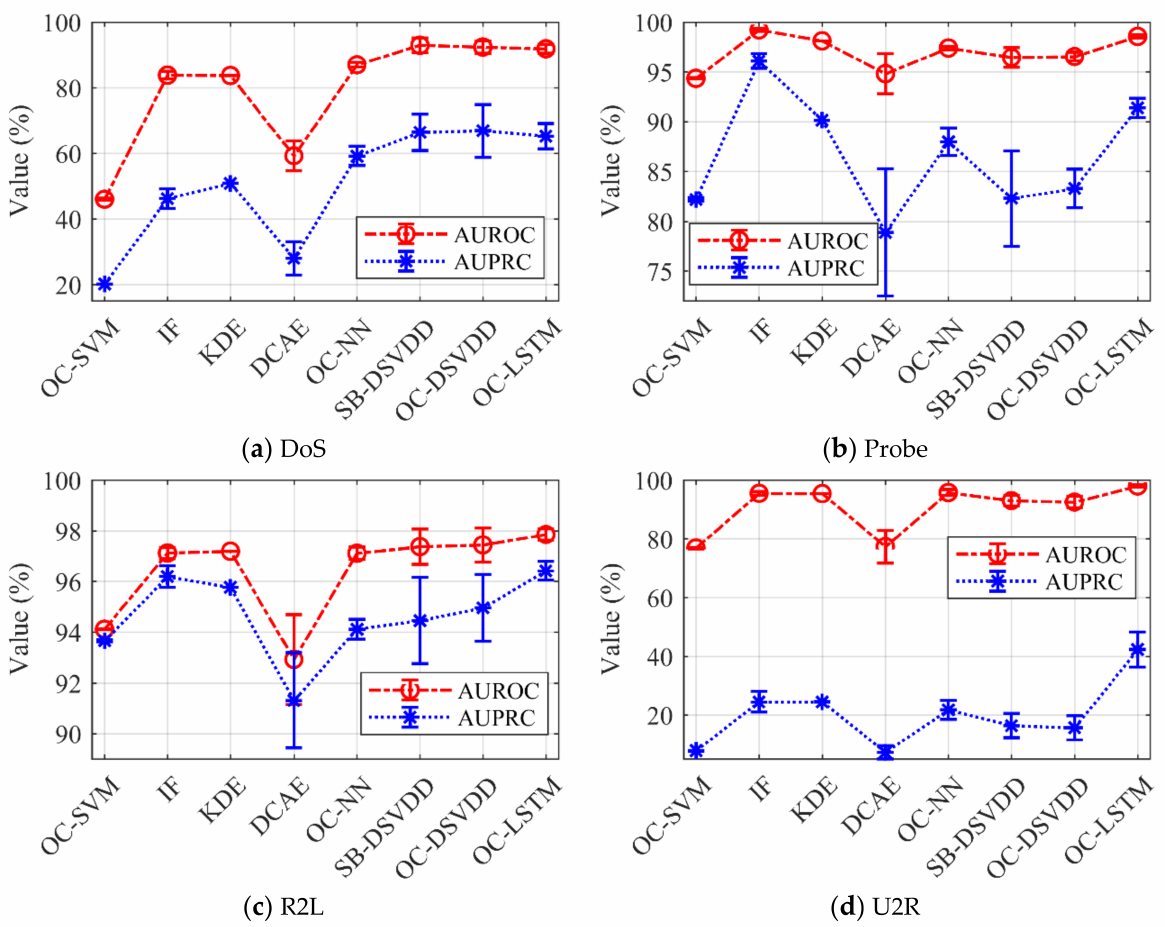
Figure 4. The detection performance of different models on NSL-KDD for various types of anomalies.